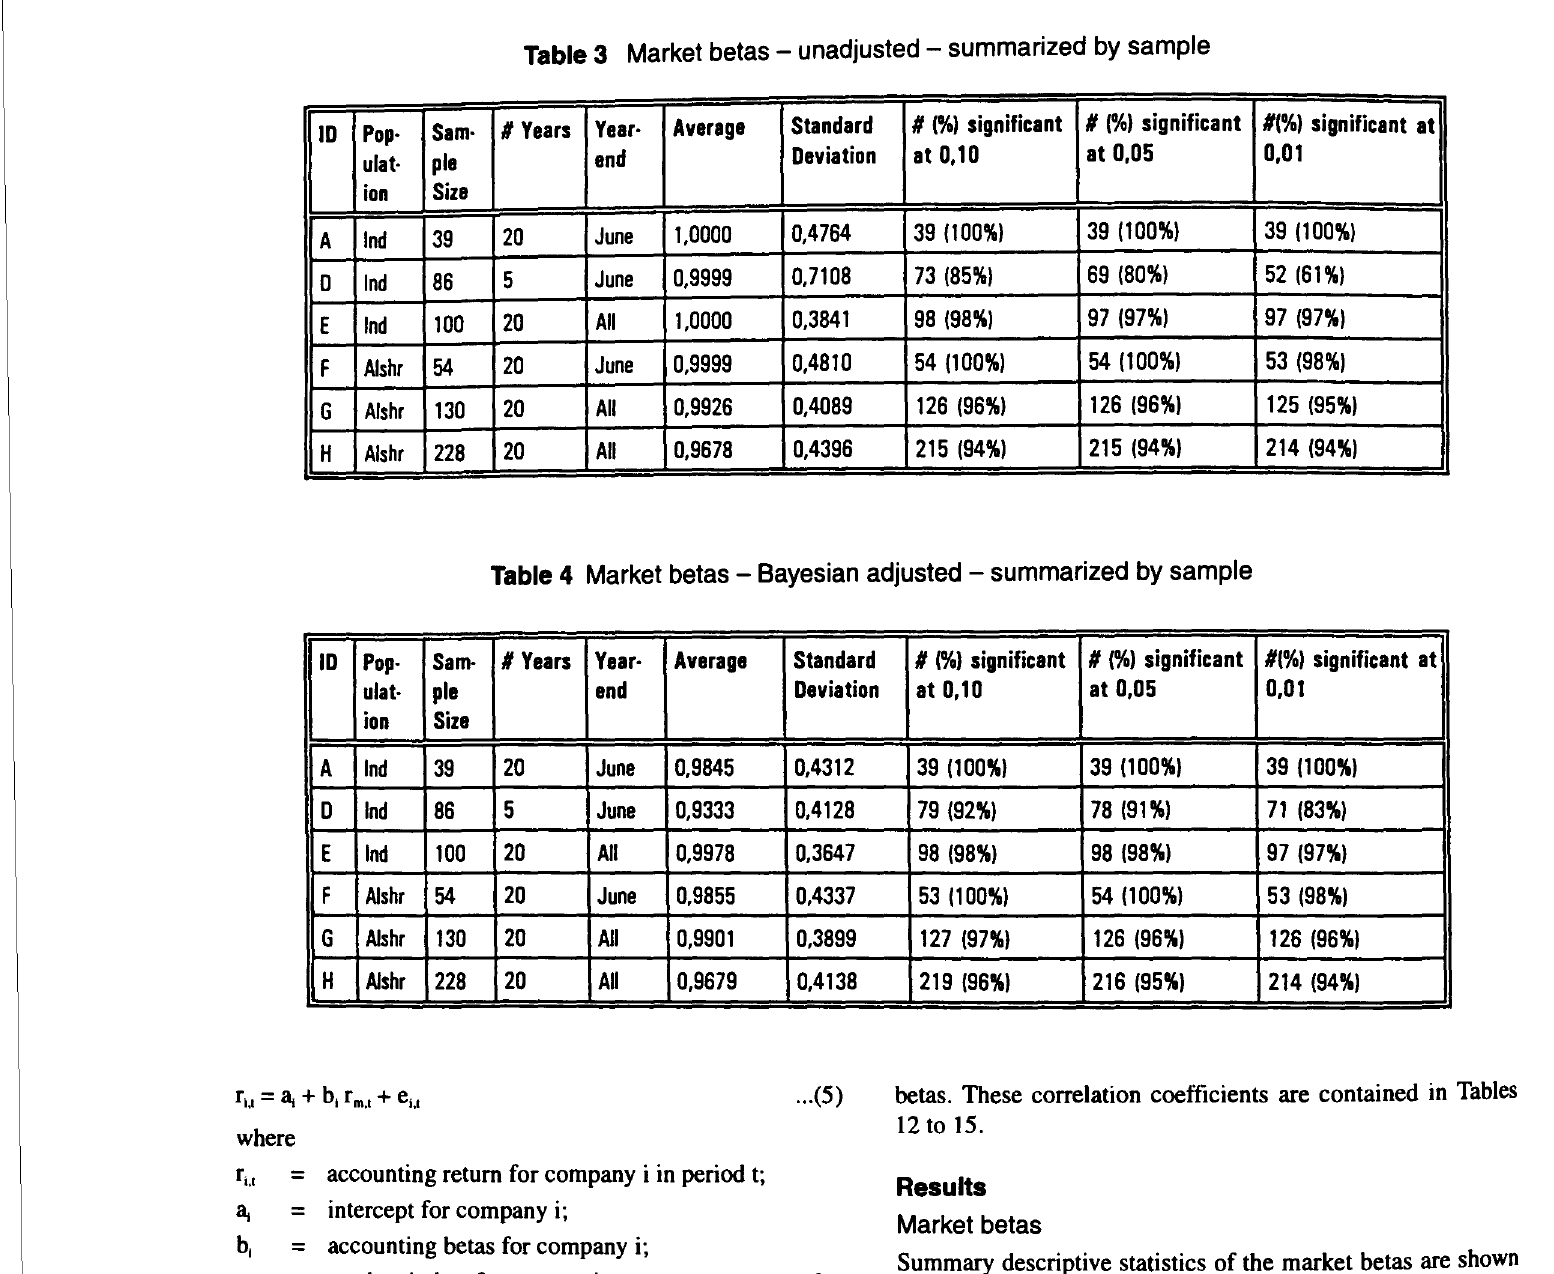
Table 4 Market betas - Bayesian adjusted - summarized by